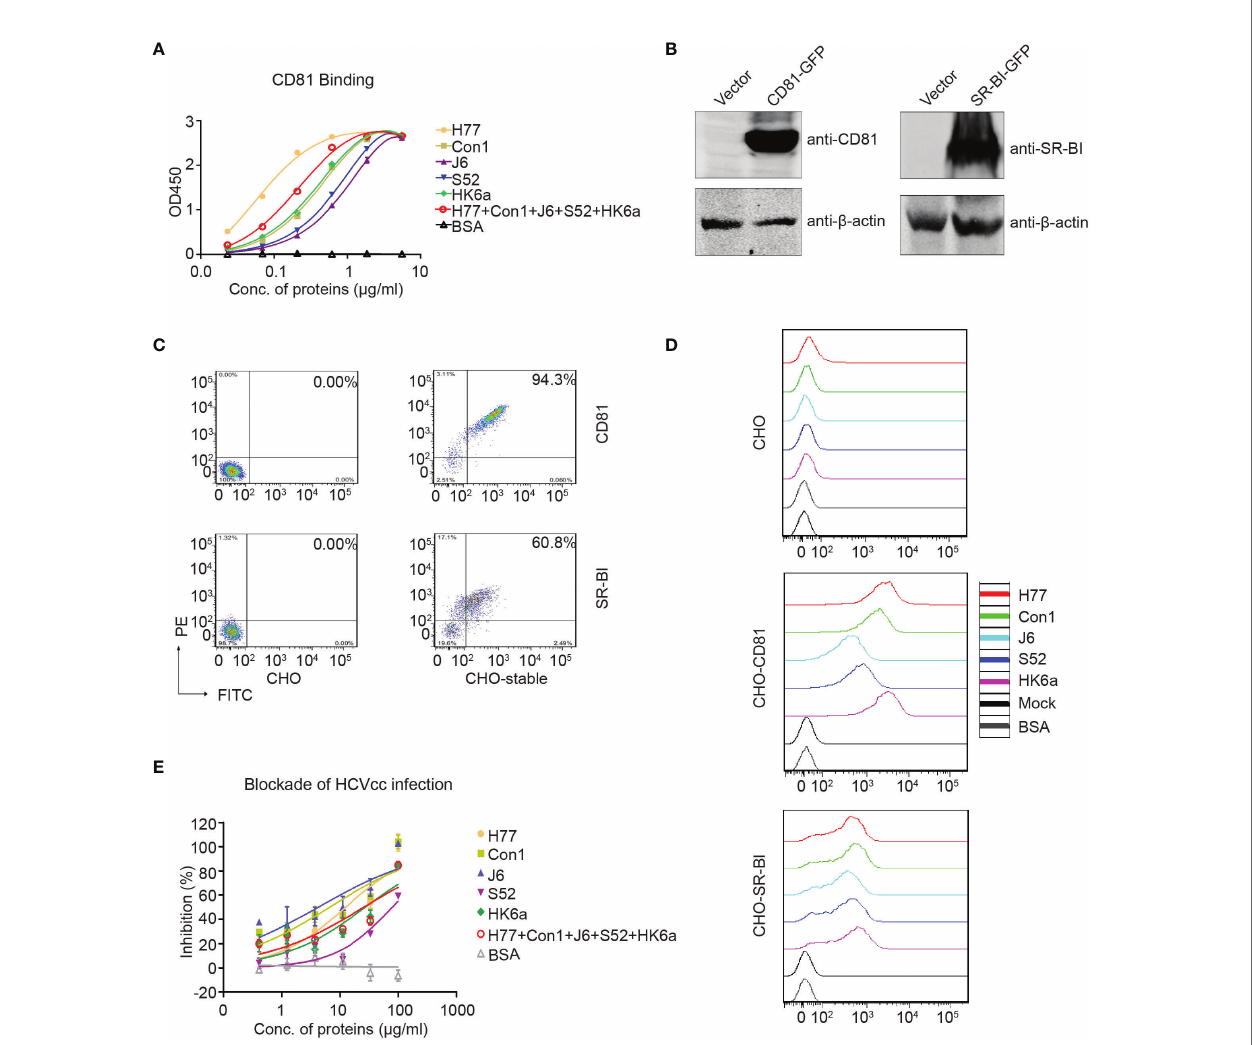
FIGURE 4 | Functional characterization of the puri fi ed Fc-E1E2 proteins. (A) CD81 binding ELISA. Precoated CD81 (0.1 m g) was incubated with Fc-E1E2 proteins at serial concentrations. Mean ± SEM of three wells were shown. (B, C) CHO cells stably expressing CD81 and SR-BI, respectively. The cells were analysis by Western blotting (B) and fl ow cytometry (C) . (D) Receptor-binding assay. Fc-E1E2 protein was incubated with cells (wild-type CHO, CHO-CD81, or CHO-SR-BI), followed by PE anti-hIgG Fc antibody and analysis by fl ow cytometry. (E) Blockade of HCVcc infection by Fc-E1E2. Serially diluted Fc-E1E2 was incubated with Huh7.5.1 cells for 1 h at 37°C, and then HCVcc was added to the mixtures to allow infection for 2 h. BSA were set as control. Core immunostaining was performed at 48 h post- infection. Means and SEM of triplicates are shown, or data are shown as a representative result from three independent